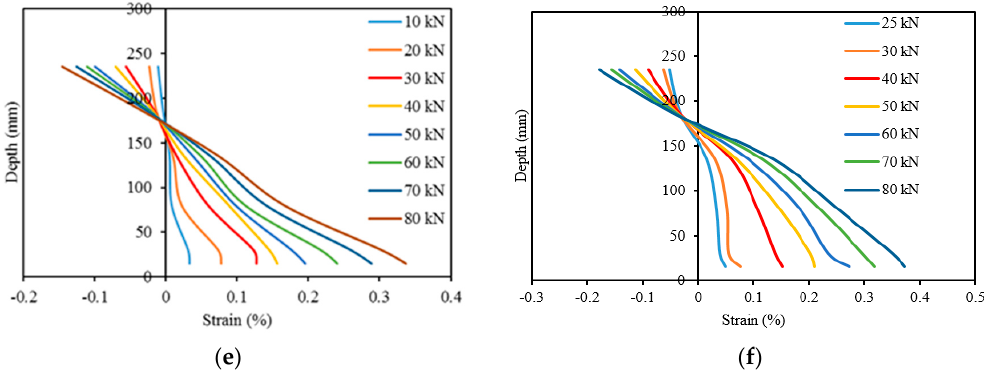
Figure 9. Sectional strain variation at mid-span during loading on strengthen beams. ( a ) CB; ( b ) N1; ( c ) N2; ( d ) N3; ( e ) N4; and ( f ) N5.